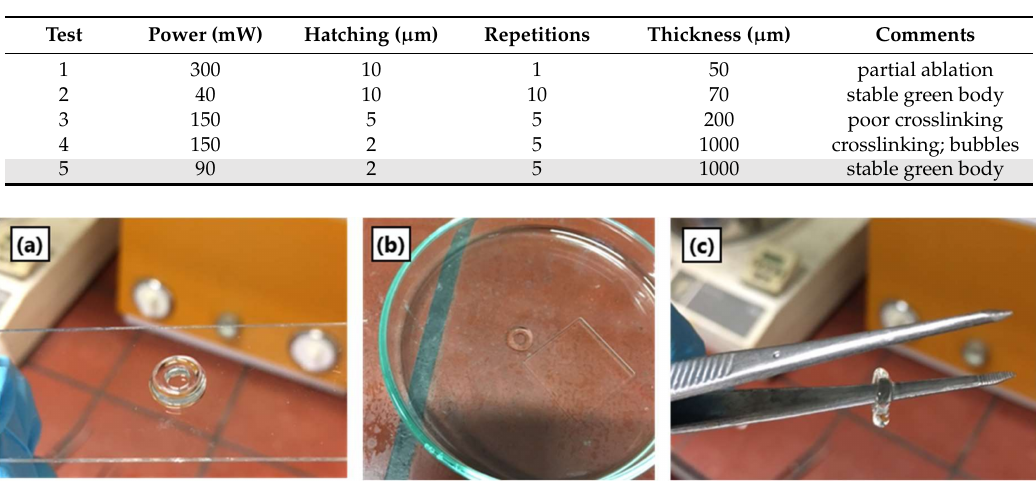
Table 3. Processing conditions tested with system 1: 266 nm laser. Entry 5 is highlighted to indicate best results.